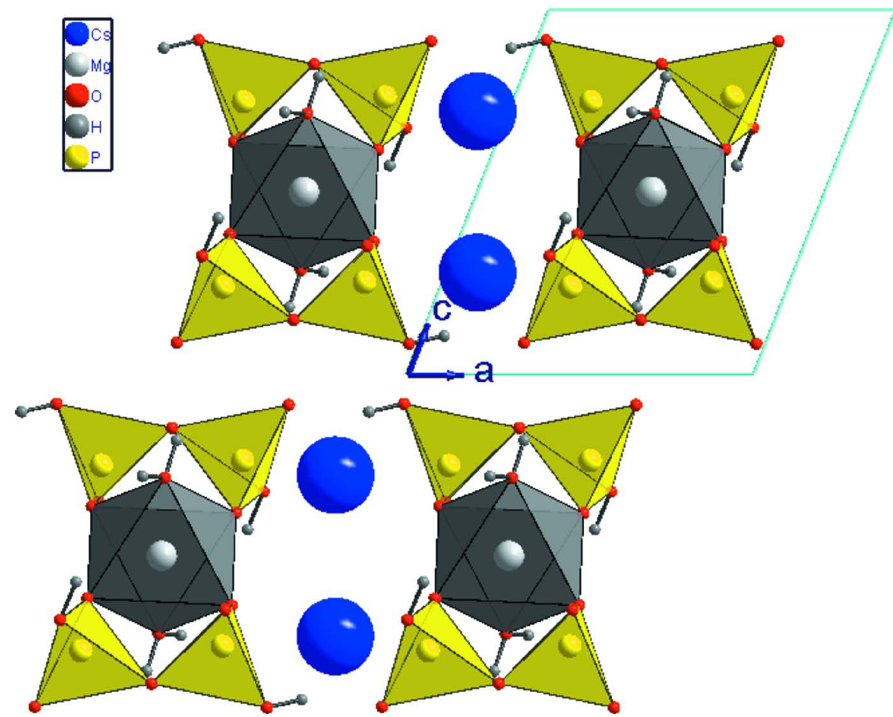
Figure 1 Crystal structure of Cs